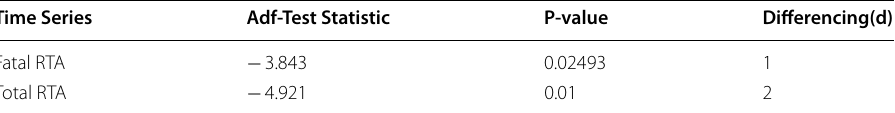
Table 5 Summary statistics for ADF test of stationarity after